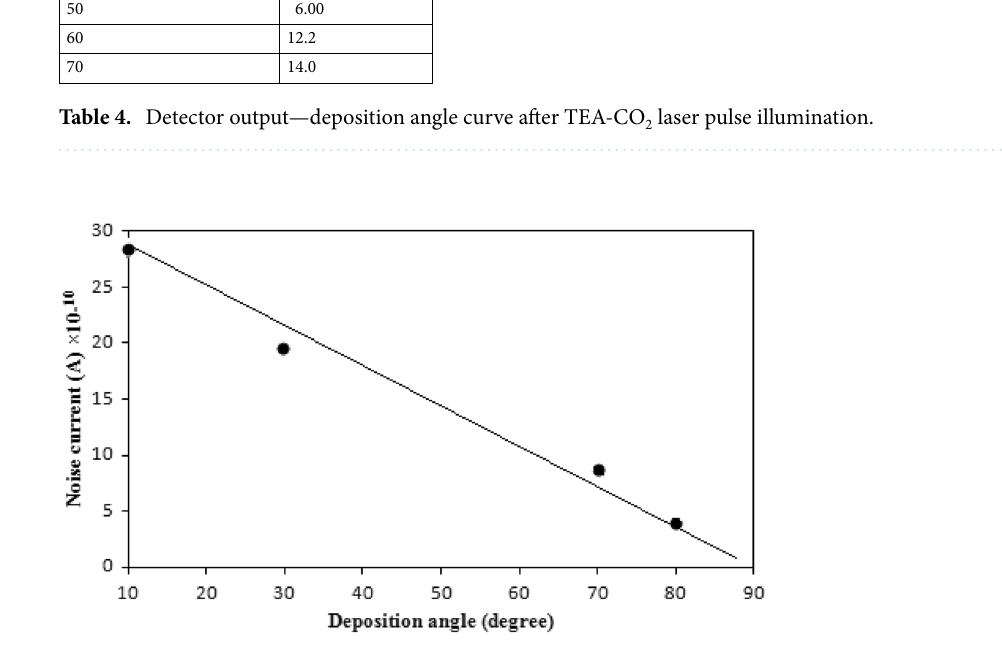
Figure 13. Noise current of the detector versus angle of